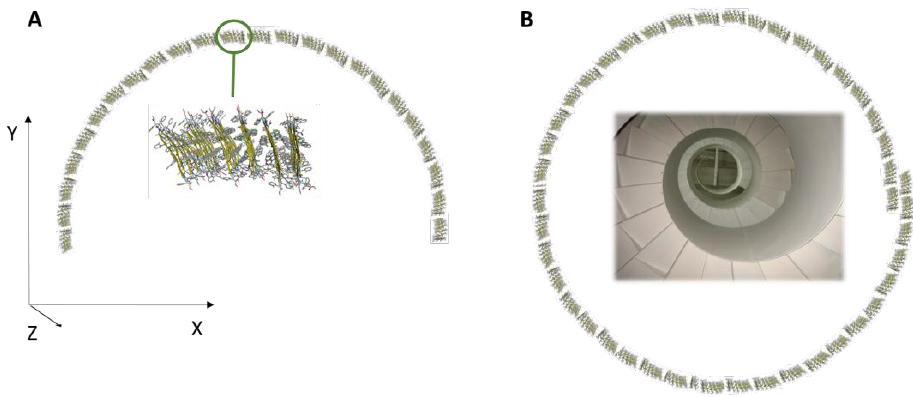
Figure 9. Views of the assembly of the 6 × 8 repetition of model peptide 1 , following the system curvature. ( A ) View of the arc. ( B ) View of the folding of the arc along the Z-axis, like a spiral staircase (inside the structure).